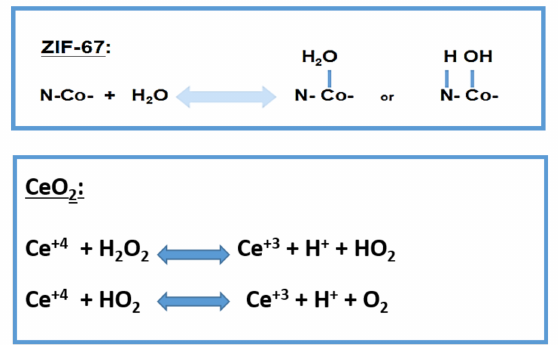
Figure 10. Active species formation on the surface of ZIF-67/CeO 2 .